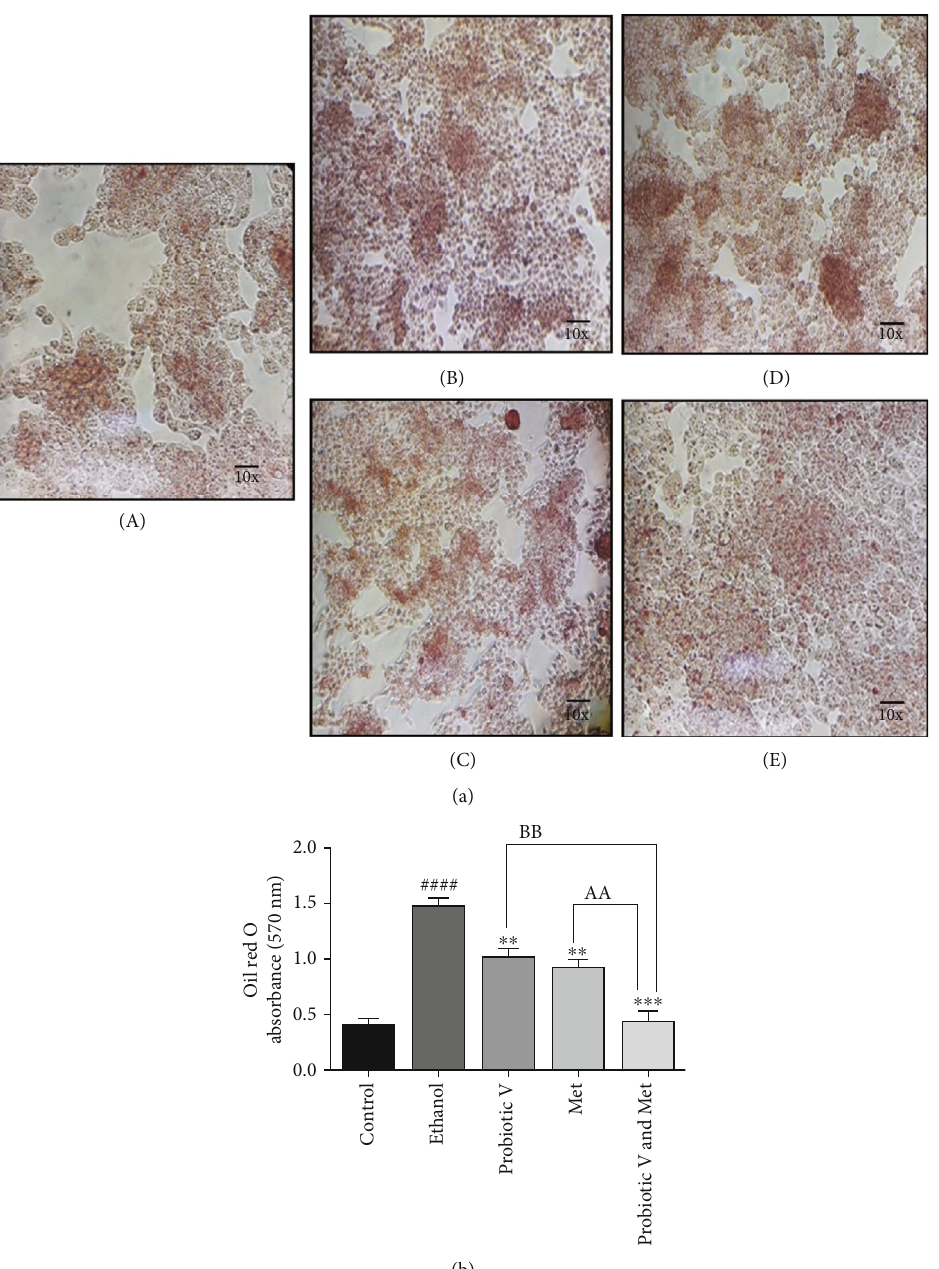
Figure 6: (a) Microscopic images of Oil red O staining showing the results of (A) control, (B) 100 mM ethanol control, (C) 100 mM ethanol +10 μ l/ml probiotic V, (D) 100 mM ethanol+1 mM Met, and (e) 100 mM ethanol+10 μ l/ml probiotic V and 1 mM Met combination exposed HepG2 cells showed increased lipid accumulation. The above images are representative of three di ff erent experiments at the 10x objective. (b) Spectrophotometric analysis results of lipid accumulation in HepG2 cells by Oil red O extraction method. Ethanol-exposed HepG2 cells cotreated with probiotic V and Met showed decrease lipid accumulation when compared to ethanol-exposed cells. Results are mean ± SD ( n = 3 individual experiments). Statistical signi fi cance was assessed by one-way ANOVA followed by Tukey post hoc test. Statistical analysis: #### p < 0 : 0001 compared with control group; ∗∗ p < 0 : 01 and ∗∗∗ p < 0 : 001 compared with ethanol group; AA,BB p < 0 : 01 compared with probiotic V and Met combinatorial